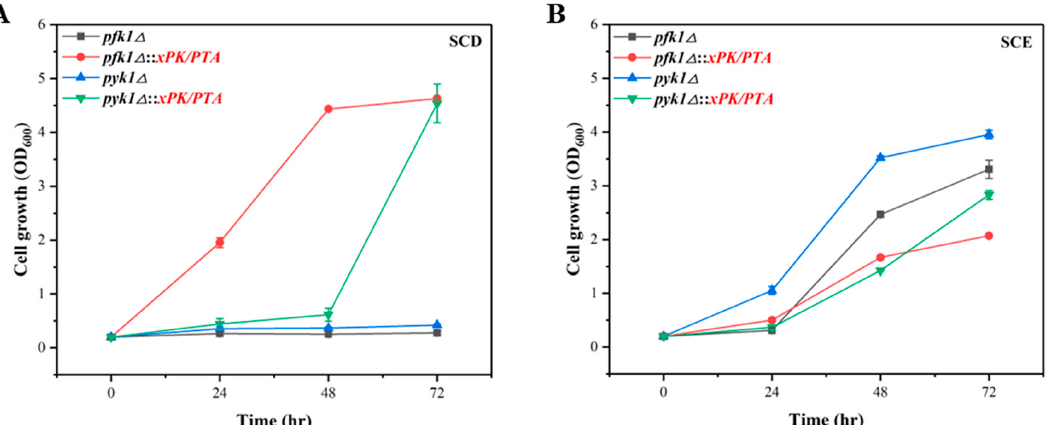
Figure 3. Verification of PK pathway in P. pastoris via growth complementation. Cell growth curves of pfk1 ∆ and pyk1 ∆ strains as well as the PK pathway integrated strains pfk1 ∆ ::xPK/PTA and pyk1 ∆ ::xPK/PTA were measured in SCD medium ( A ) and SCE medium ( B ). The data represent three biological replicates, and the error bars represent standard deviations.